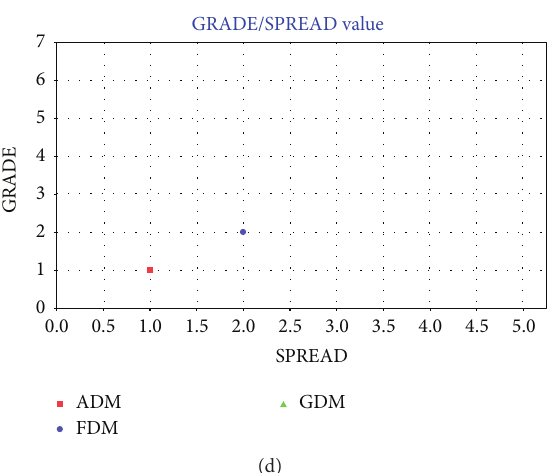
Figure 6: Agreement cases for out-of-phase responses with 1D FSV tool: (a) ADMi and FDMi, (b) ADMc and FDMc, (c) GDMi and GDMc, and (d) GRADE/SPREAD chart.